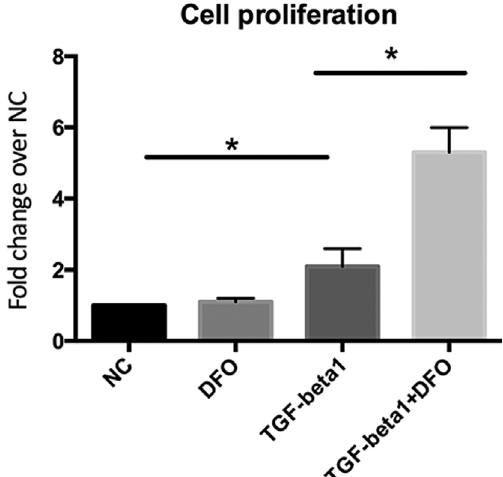
Figure 2 - DFO synergizes with TGF- (cid:15) 1 in the proliferation of ATDC5 cells. The cells were treated with DFO, TGF- (cid:15) 1 or both for three days, af- ter which cell proliferation was assessed using the AlamarBlue ® assay. The columns represent the mean + 1 SD of the fold-change in cellular pro- liferation relative to non-treated control cells (NC) (n = 3 each). *p < 0.05 for cells treated with TGF- (cid:15) 1 vs. NC cells and for cells treated